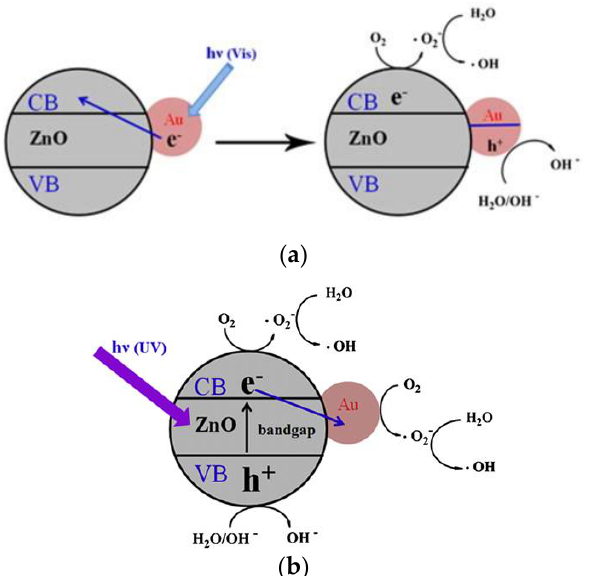
Figure 7. ( a ) Surface plasmon resonance (SPR) induced ROS generation in AuNPs-doped ZnO hybrid under visible light. SPR-generated hot electrons flow to the CB of ZnO. ( b ) Photoexcited electrons from ZnO flow to AuNPs under UV irradiation. Reproduced from [72] with permission of Elsevier . The localized SPR intensity and wavelength depend on the factors a ff ecting the electron